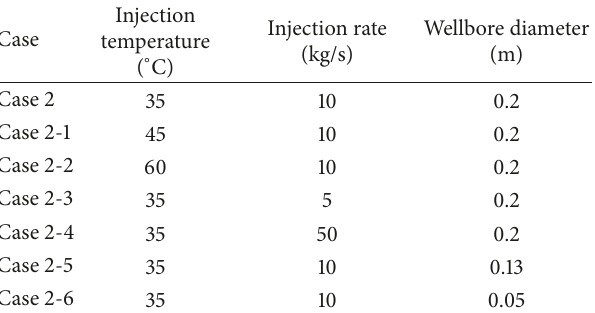
Table 2: Description of sensitivity